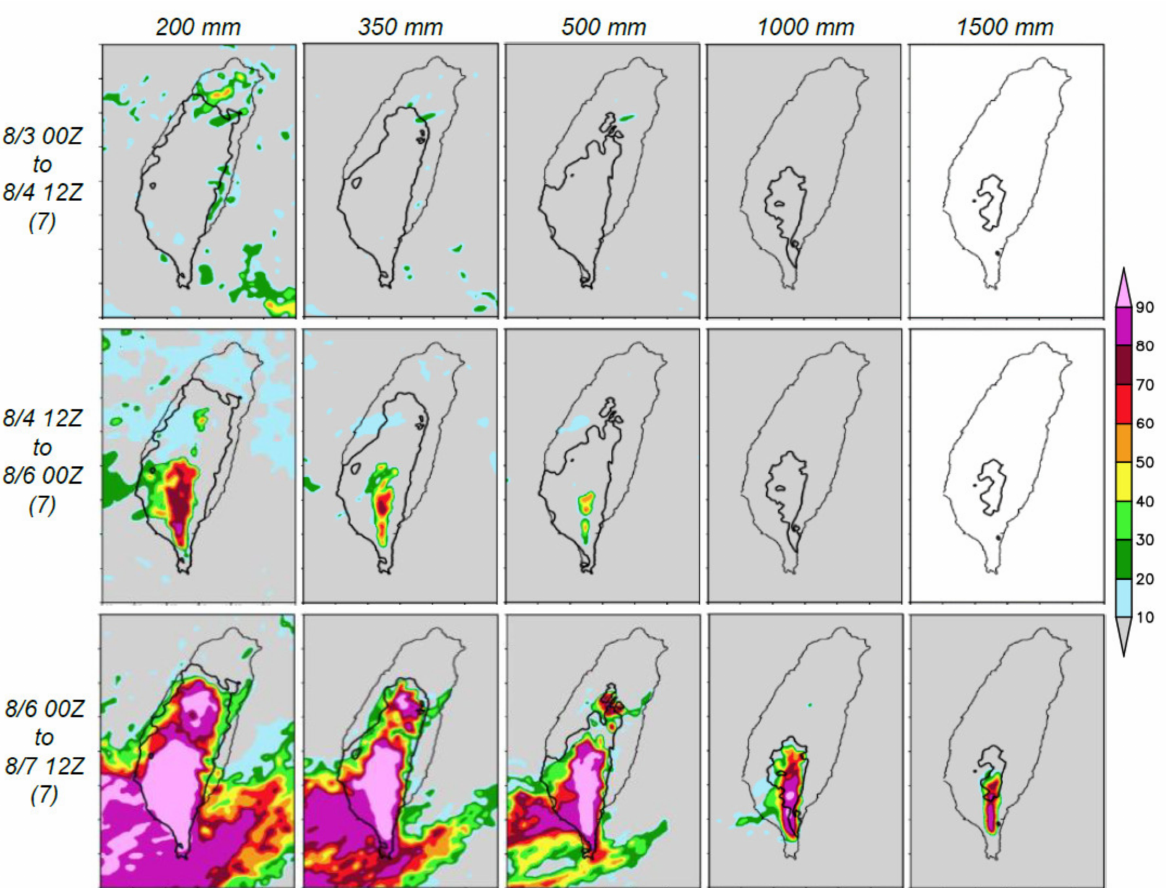
Figure 8. Probabilities of 48-h QPFs (%, color) from seven successive time-lagged members shown in Figure 7, with t 0 between ( top row ) 0000 UTC 3 and 1200 UTC 4, ( middle row ) 1200 UTC 4 and 0000 UTC 6, and ( bottom row ) 0000 UTC 6 and 1200 UTC 7 August (as labelled on left), to reach the thresholds of 200, 350, 500, 1000, and 1500 mm ( left to right ), respectively, for the target period of 1200 UTC 7 to 1200 UTC 9 August during TY Morakot (2009). The observed areas (over land) at each respective threshold are depicted by the thick black contours. For each group, the weights assigned to each member are 1/28, 2/28, . . . , 7/28, from the earliest to the latest, with a total weight of